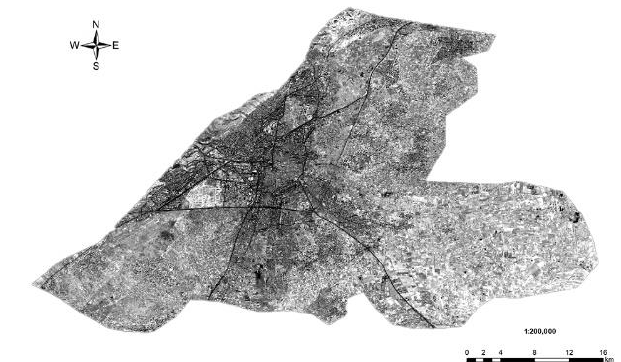
Figure 1 : Map of the study area